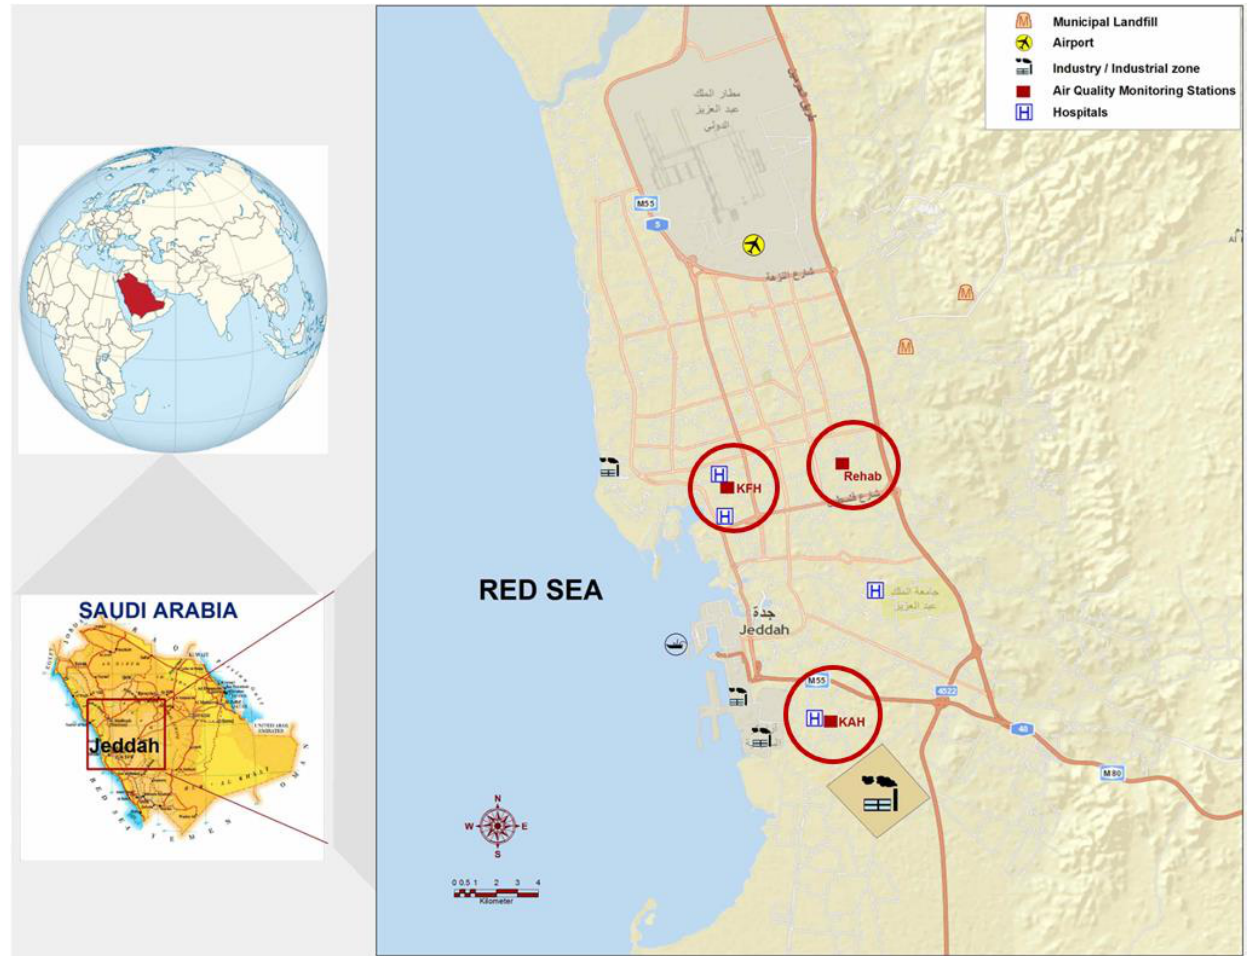
Figure 1. Map of Jeddah showing the sampling sites (King Abdul-Aziz Hospital (KAH), King Fahad Hospital (KFH), King Abdul-Aziz University (Al-Rehab/KAU)), industrial areas, major roads, and hospitals. Al-Rawda sampling site not depicted.